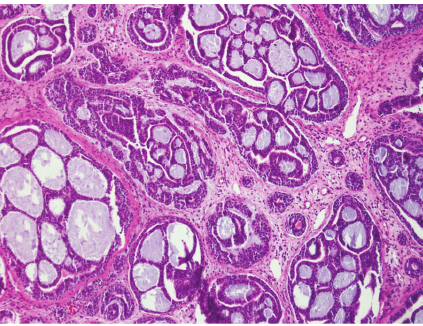
Figure 2: ACC cribriform pattern, characterized by nests of cells with mucopolysaccharide-filled spaces.